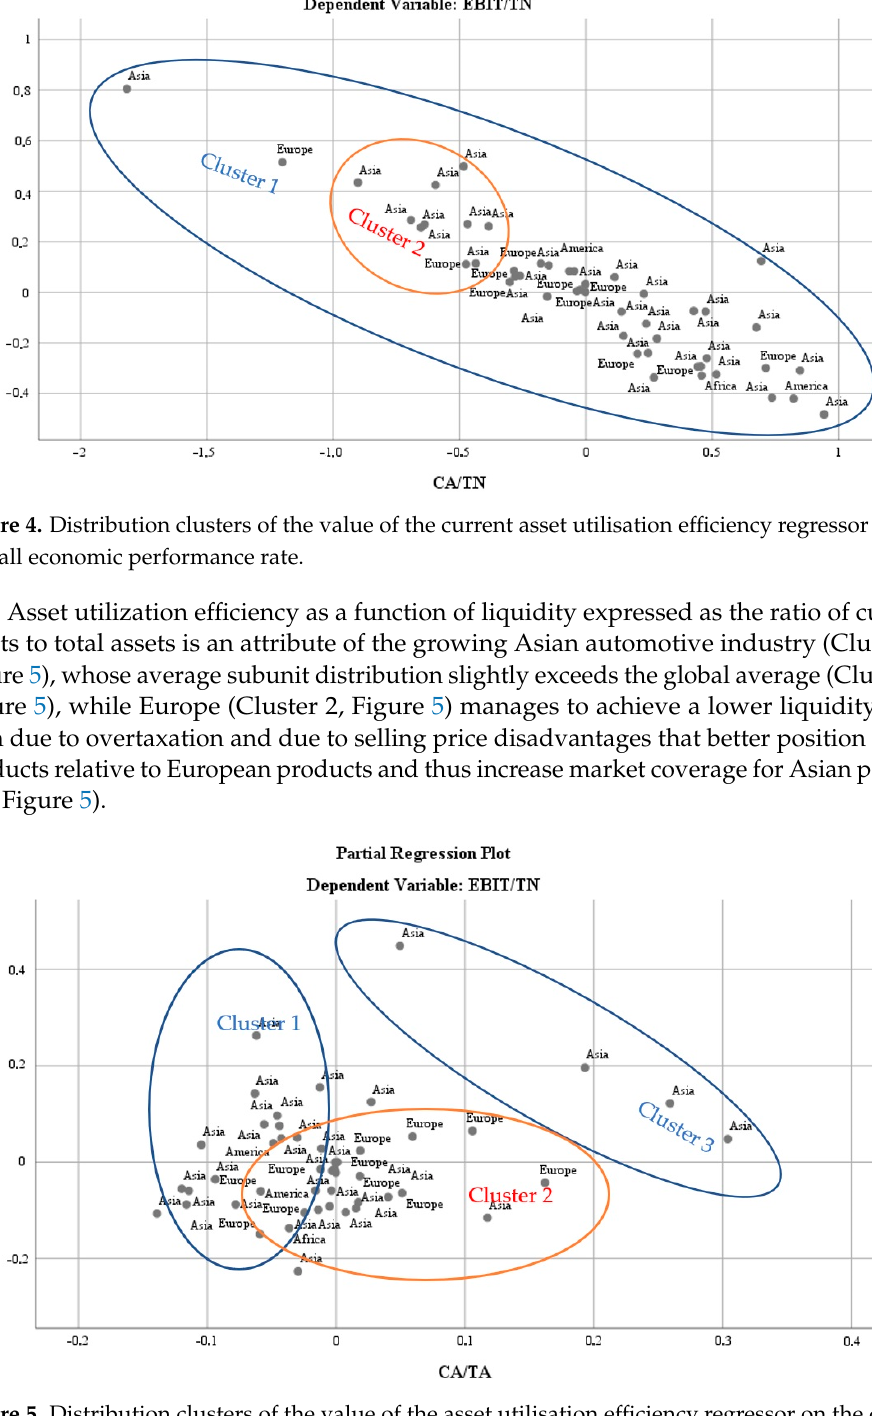
Figure 3. Distribution clusters of the value of the productive efficiency regressor in relation to the overall economic performance rate.